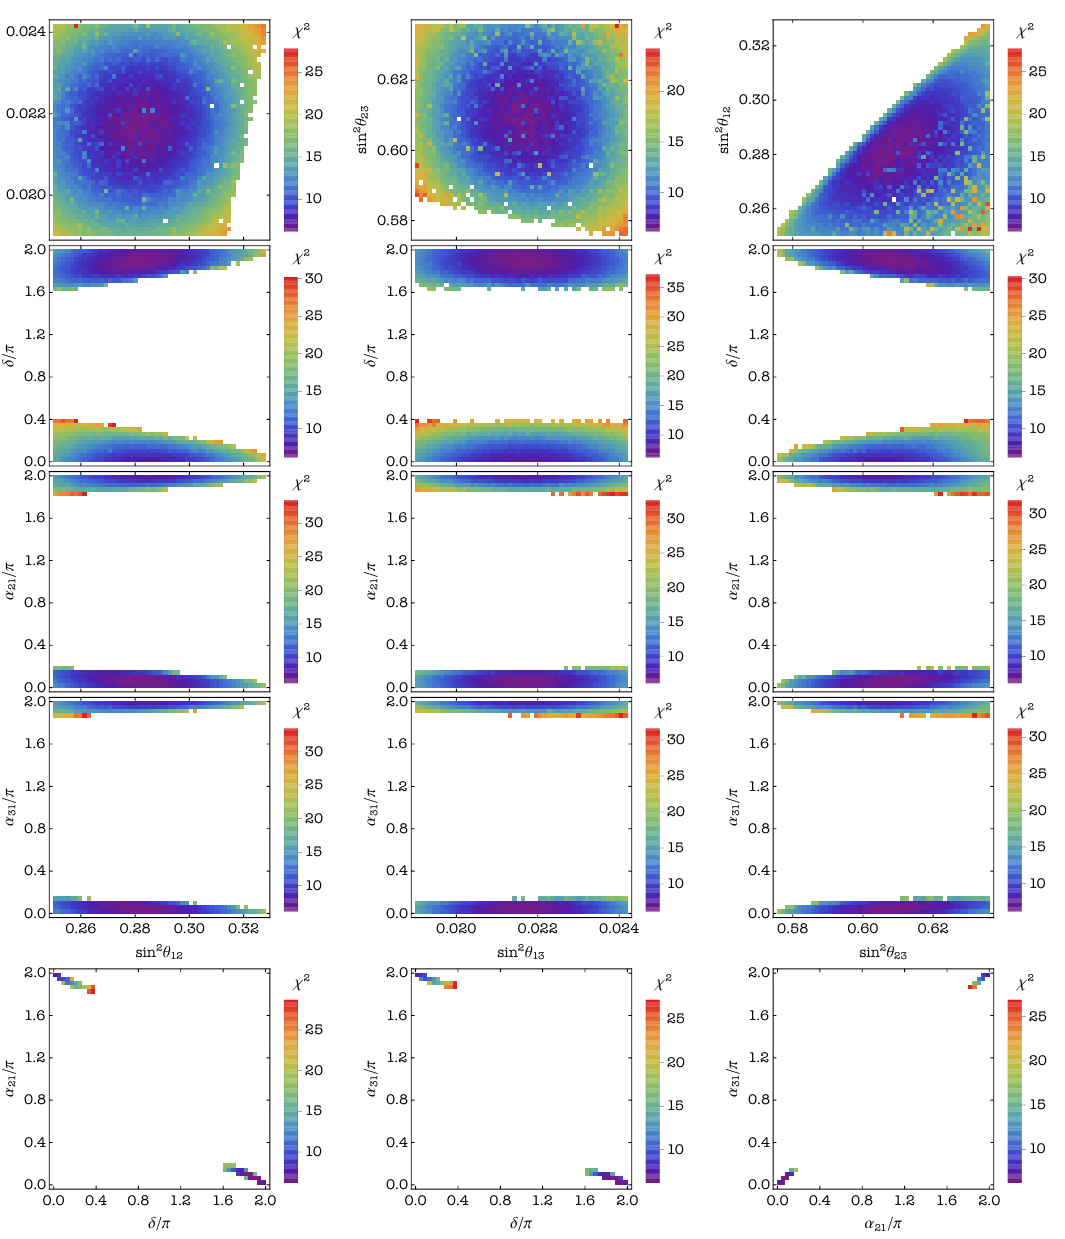
Figure 2 . Correlations between the neutrino mixing parameters in case B2. The values of all the three mixing angles are required to lie in their respective 3 (cid:27) ranges. Colour represents values of (cid:31) 2 for the IO neutrino mass spectrum.